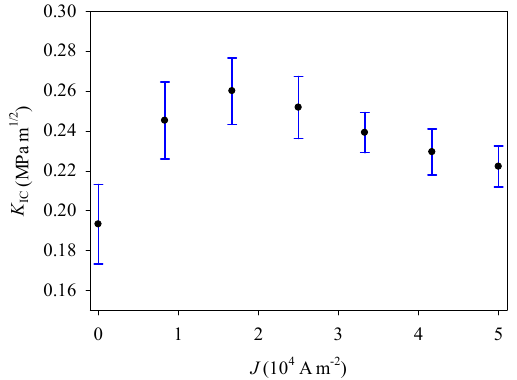
Figure 8. The relationship of K IC with the applied electric current density.